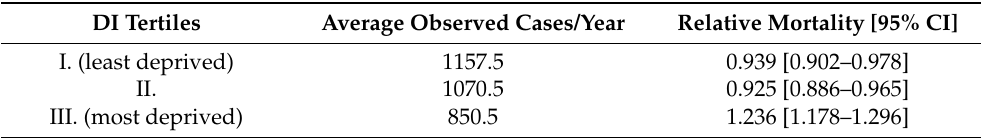
Figure 1. The territorial inequalities of deprivation ( A ) and mortality due to diabetes mellitus among people aged 20 years and over ( B ), at district level in Hungary, 2018–2019. Table 1. The risk of mortality due to diabetes mellitus for 20–X age group at district level by deprivation tertiles, compared to the national average mortality in Hungary, 2018–2019.